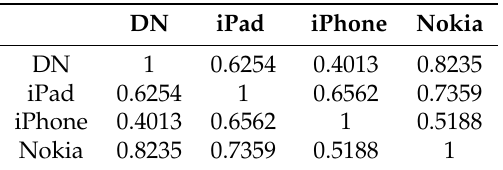
Table 6. R 2 values for 50.000 bin histograms for iPerf TCP IATs for traces concatenated by same device